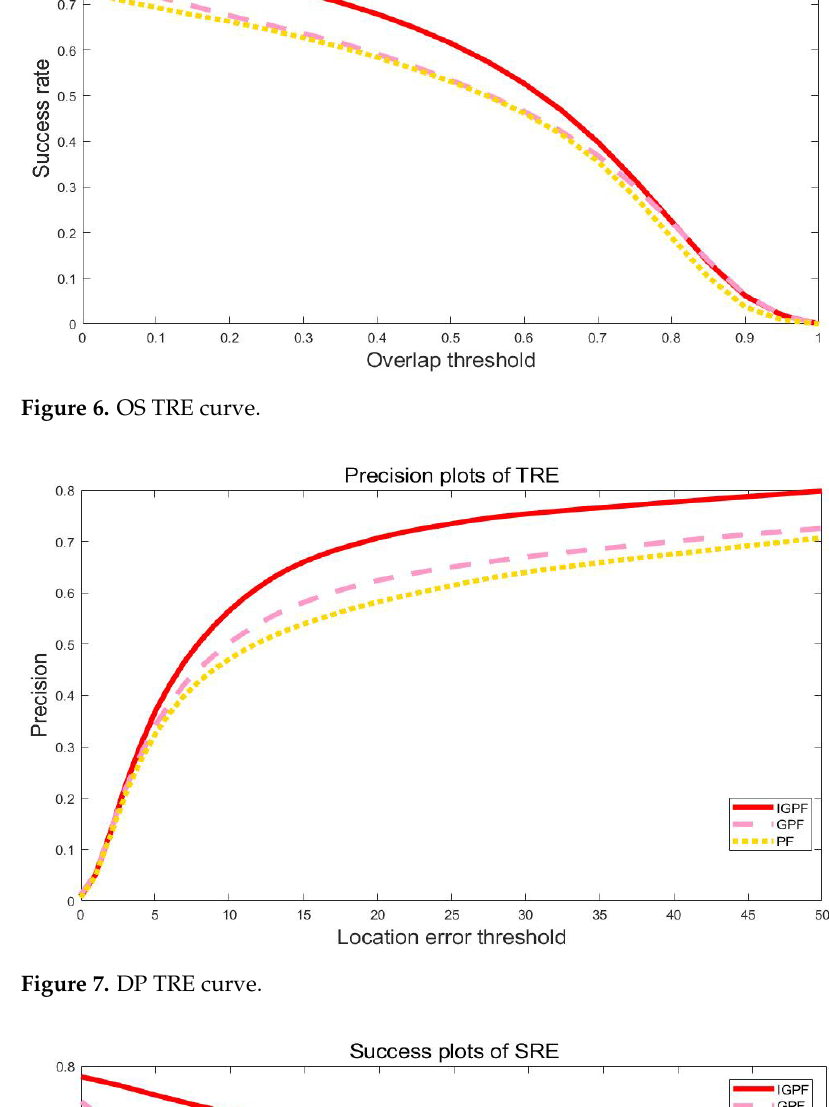
Figure 5. DP OPE curve.